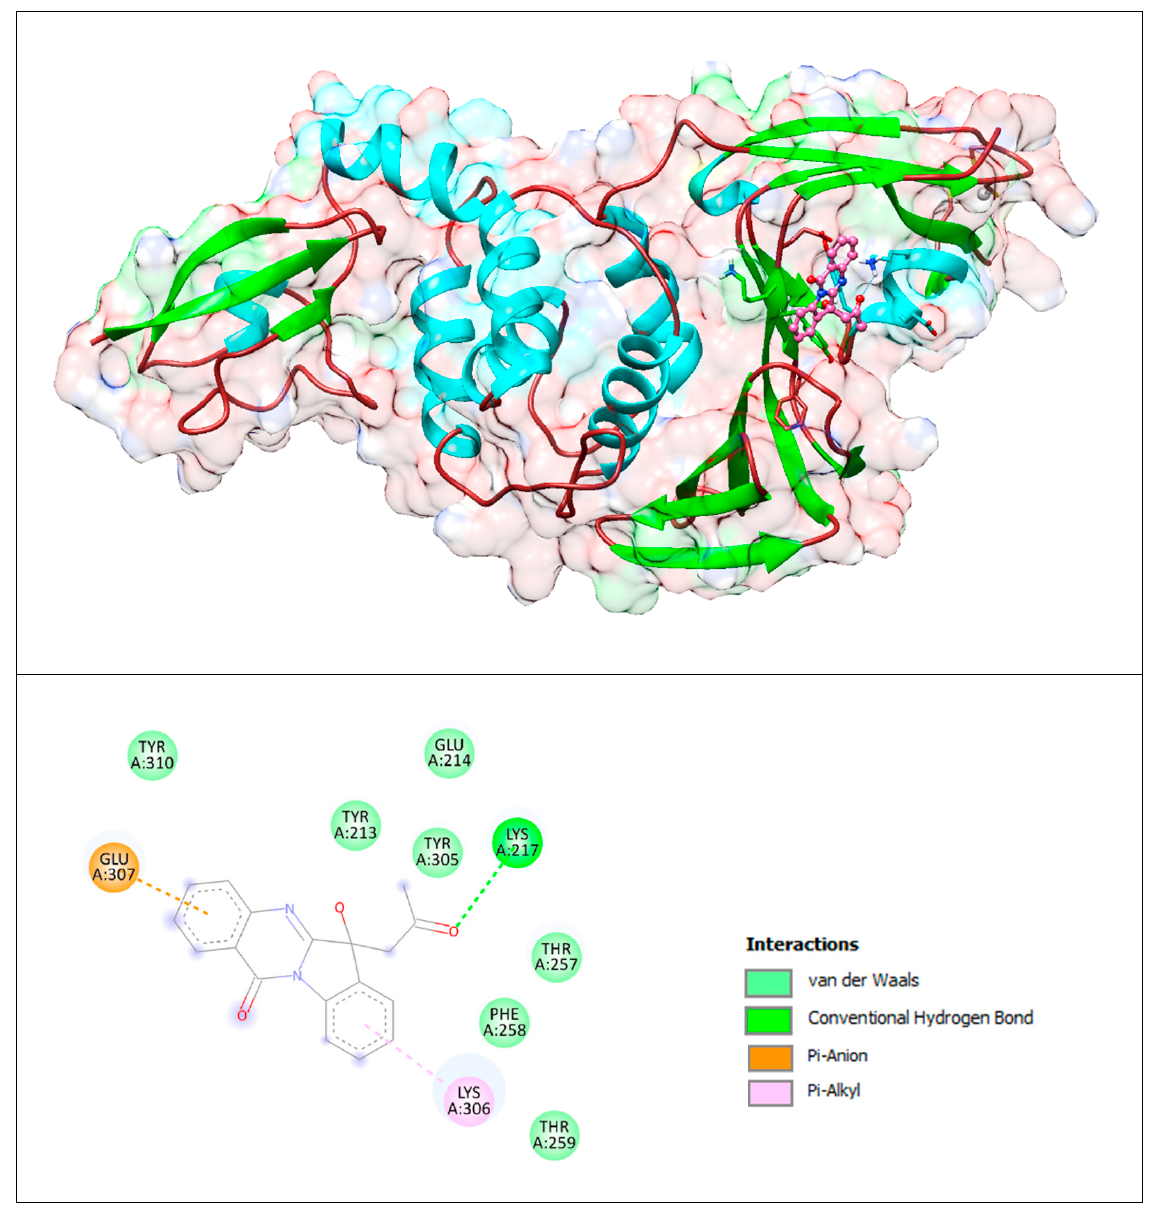
Figure 9. Complex of PLpro with PAA. The upper panel shows a 3D model of PLpro with a binding site (cavity) on its surface for the PAA compound. The lower panel shows the binding mode of PAA with the amino acid residues of PLpro. Figure 9 was created with UCSF Chimera ( upper panel ) and BIOVIA Discovery Studio Visualiser ( lower panel ) and shows the best docking pose of compound PAA on PLpro. We should also see where PAA is placed on the PLpro surface and a general view of the complex of PLpro (green–cyan–brown) with PAA (pink). The secondary structure of the protease behind the molecular surface (created with 90% transparency for better presentation of the molecule) is also shown.